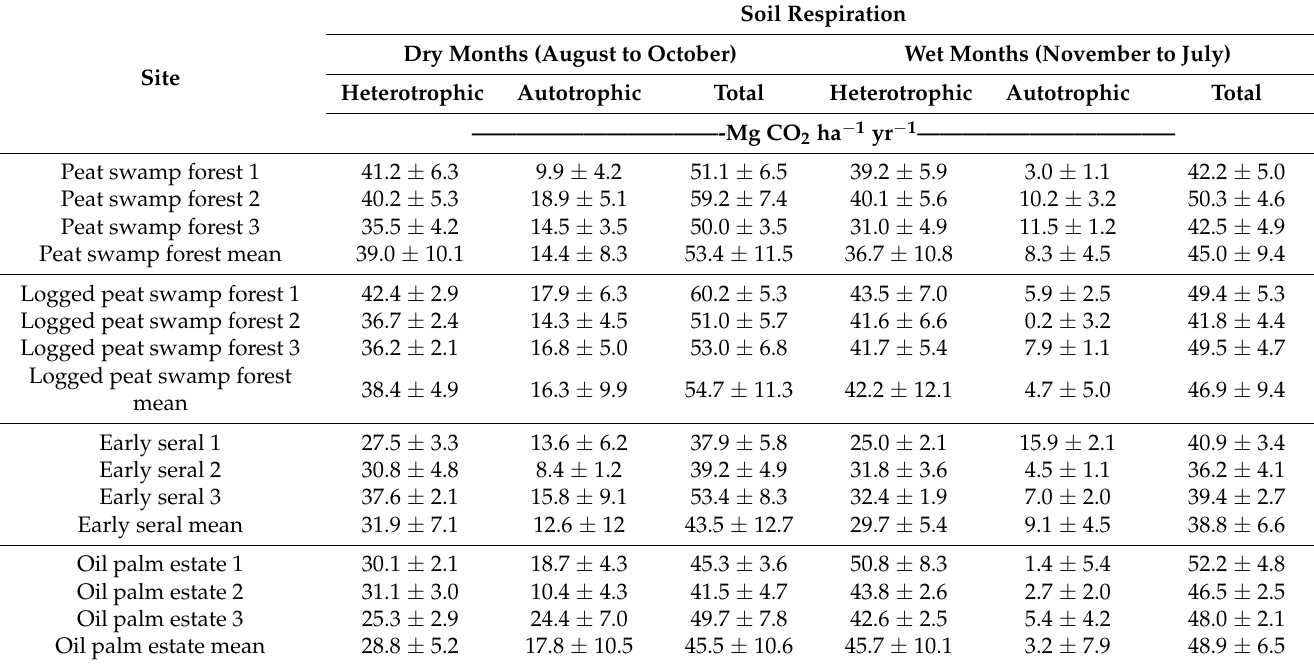
Table 3. Heterotrophic, autotrophic, and total respiration during dry and wet months in intact forest, logged peat forest, early seral, and oil palm estate. Data are mean ± one standard error.